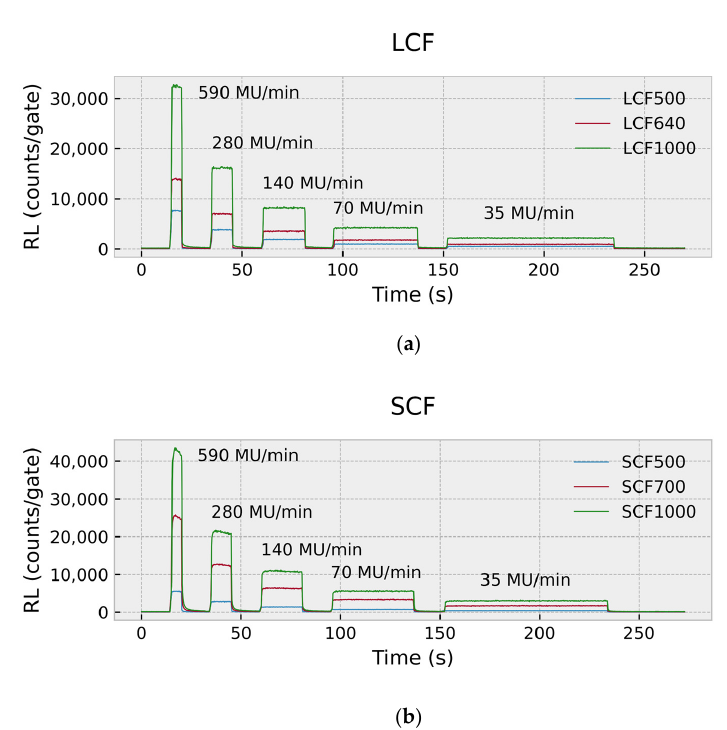
Figure 6. RL response (gate time of 100 μ s) of the ( a ) LCF and ( b ) SCF samples exposed at a fixed dose of 0.5 Gy.